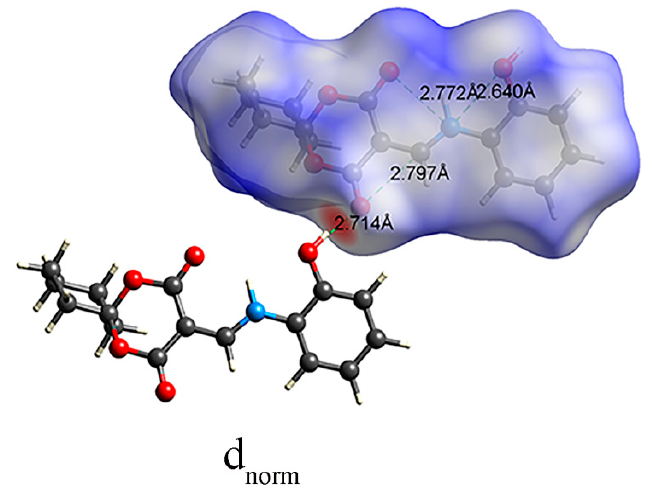
Figure 8. The d norm Hirshfeld surface for HMD. As seen in Figure 9, the H ··· H interactions with a single peak composed 46.4% of the HS, which denoted the largest contribution of the total HS. The O ··· H/H ··· O interactions observed as a wing covered 34% of the total HS, whereas the C ··· H/H ··· C interactions accounted for 11.5%. Other intercontacts, including C ··· C, H ··· N/N ··· C, C ··· O/O ··· C, and N ··· H/H ··· N, accounted for 4.2%, 2.3%, 1.4%, and 0.1%,